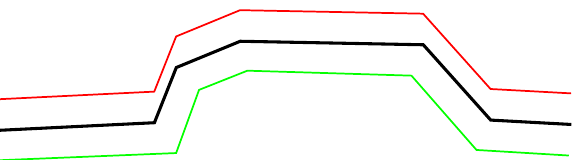
Figure 10: Starting from center line (black), a translation would not create correct a lane (red). We must use the buffer (green).